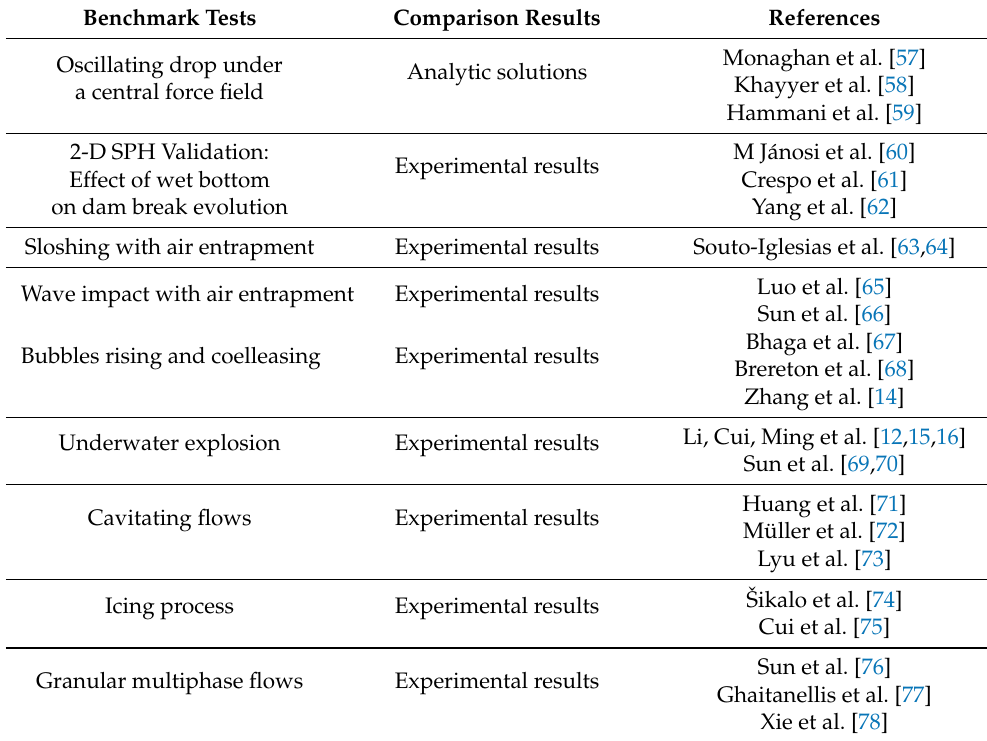
Table 1. Benchmark tests of SPH simulations for multiphase